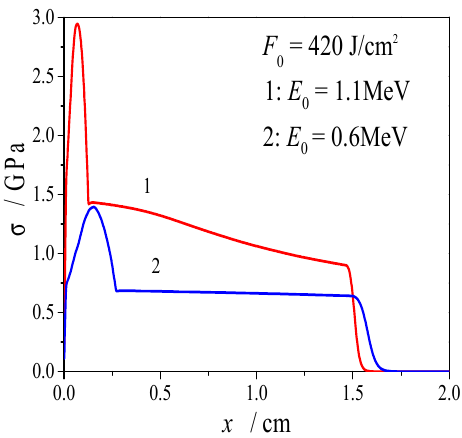
Figure 14. Thermal shock wave attenuation in carbon phenolic. Figure 15 shows the spatial waveforms of thermal shock waves generated at different times under electron beam radiation in carbon phenolic with an average energy of 1.1 MeV and an incident energy density of F 0 = 420 J/cm 2 . Figure 11 shows the calculated results of stress peaks in carbon phenolic target plates under different energy radiation. Figure 12 shows the calculation results of stress peaks in carbon phenolic under the same incident energy of 1.1 MeV and different energy